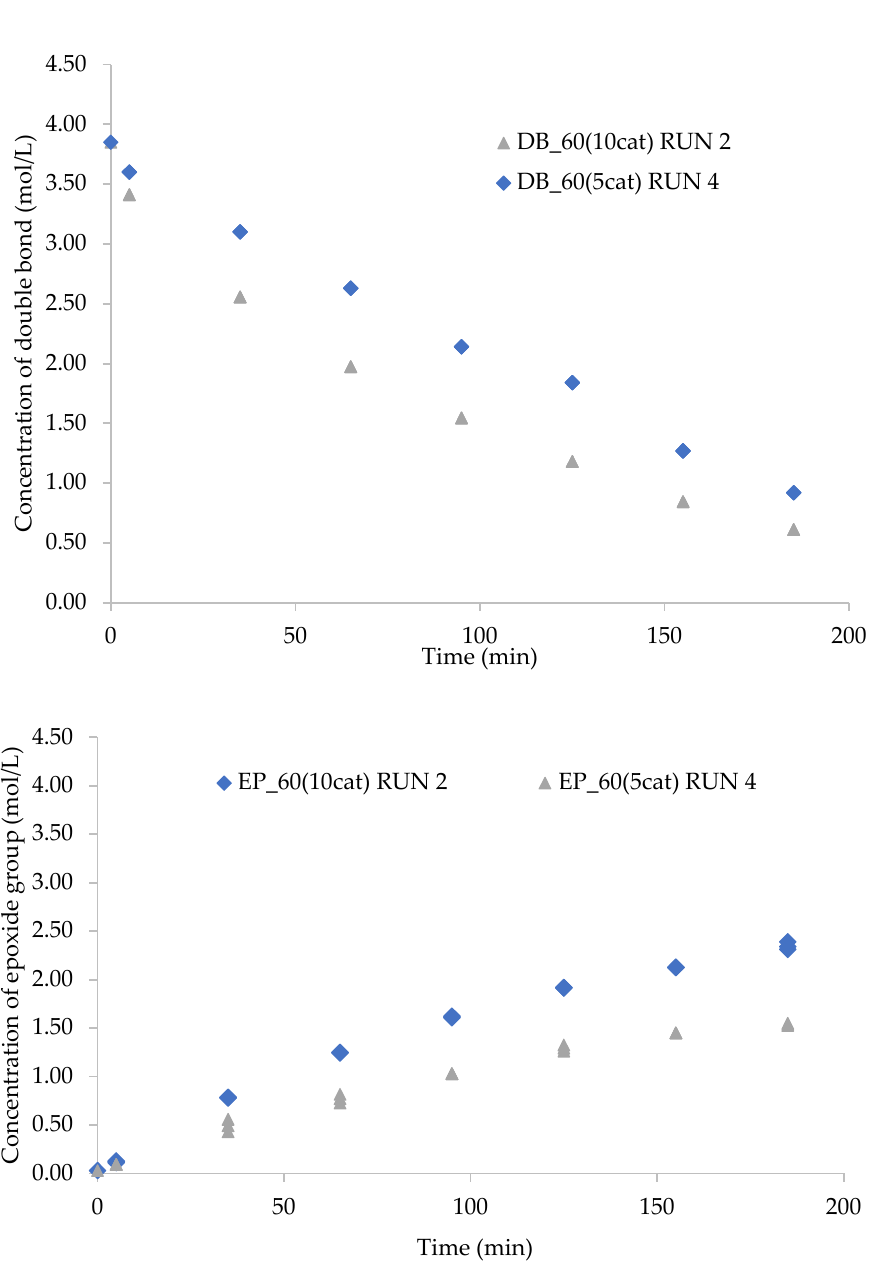
Figure 8. Effect of catalyst loading on the rate of epoxidation.